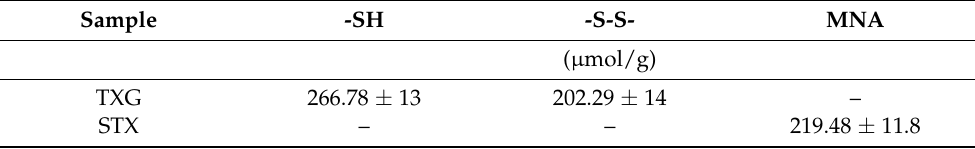
Table 6. The quantity of thiol and disulfide groups was estimated by quantitative